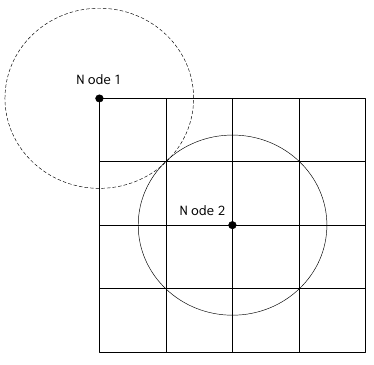
Figure 8. Neighbors in the communication range of one node.